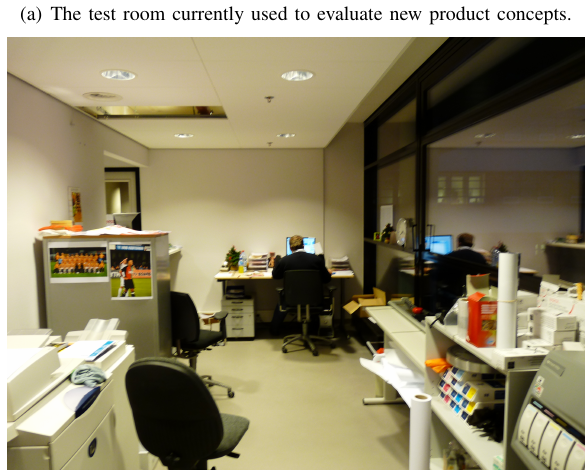
Fig. 2. Participants in product evaluations (e.g. printer operators) should feel ‘at home’ during a product evaluation, which can not be achieved in the current test lab (figure 2(a)). VR is used to create a more realistic and familiar test environment.